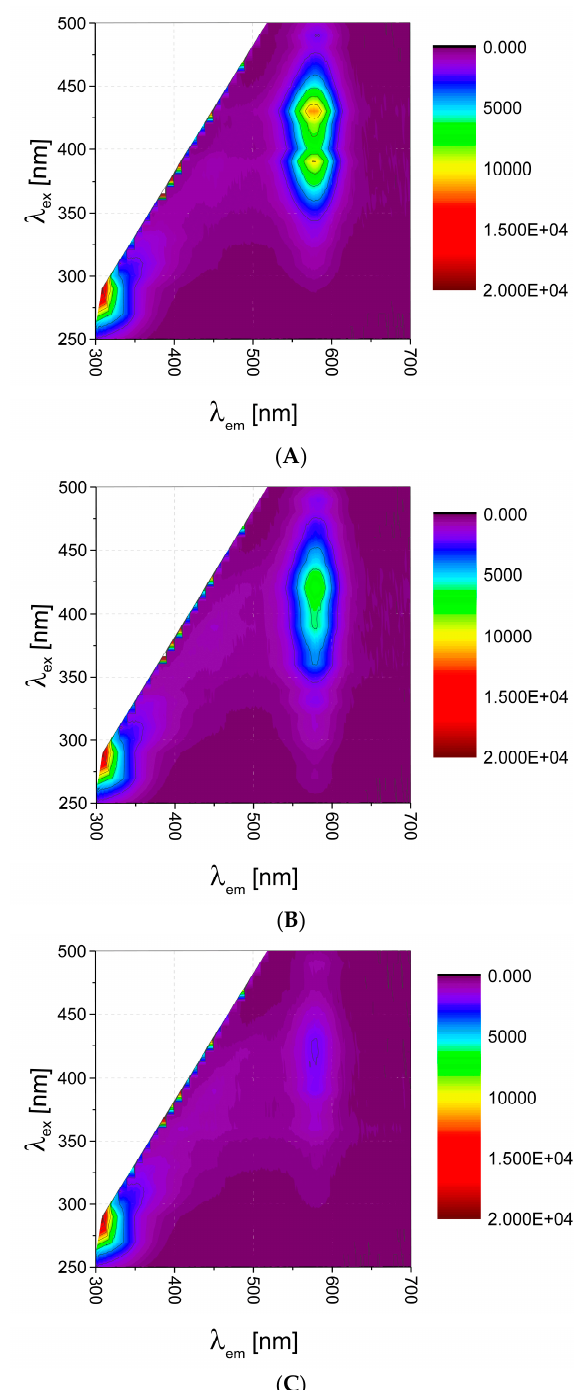
Figure 1. 2D fluorescence map for ( A ) quantum dots λ em = 585 nm, PBS pH 7.0; ( B ) quenching after addition of 1 mM Arg in PBS pH 7.0; ( C ) quenching after addition of 1 mM Gly-Ala, PBS pH 7.0.